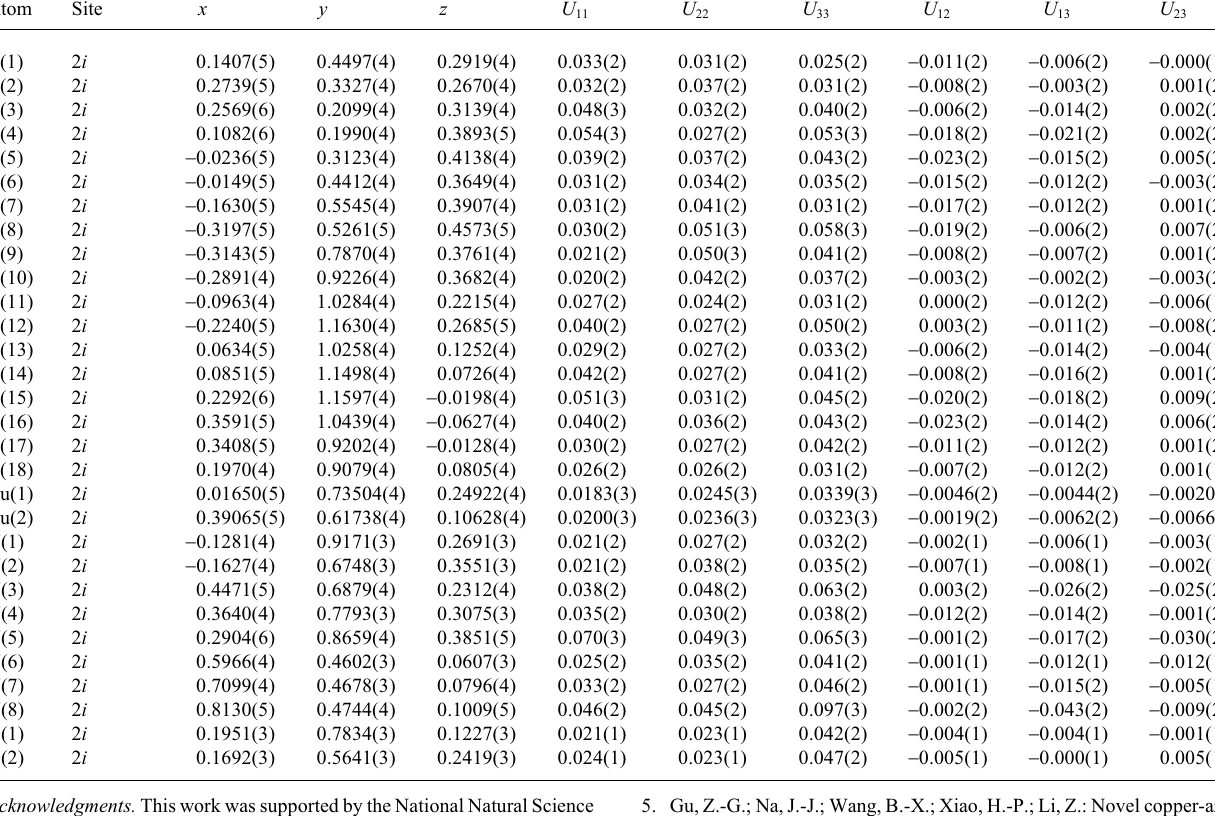
Table 3. Atomic coordinates and displacement parameters (in Å 2 )